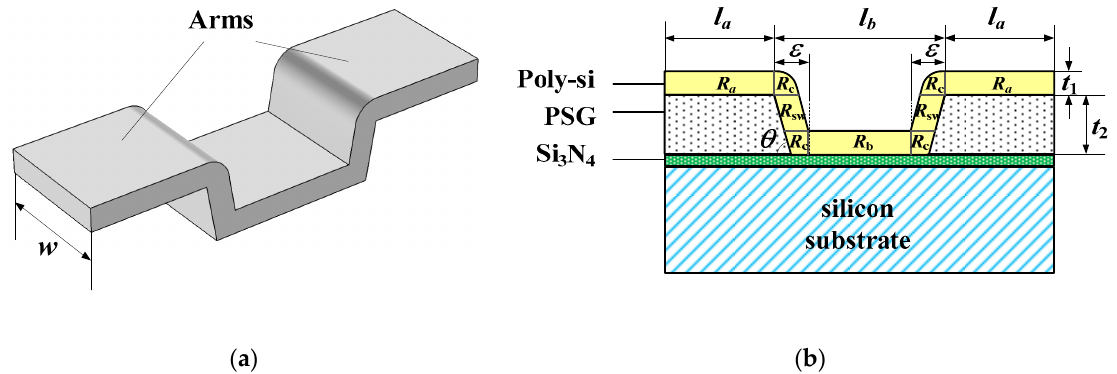
Figure 1. Schematic diagrams of a step structure: ( a ) 3-D view; ( b ) Cross section view.